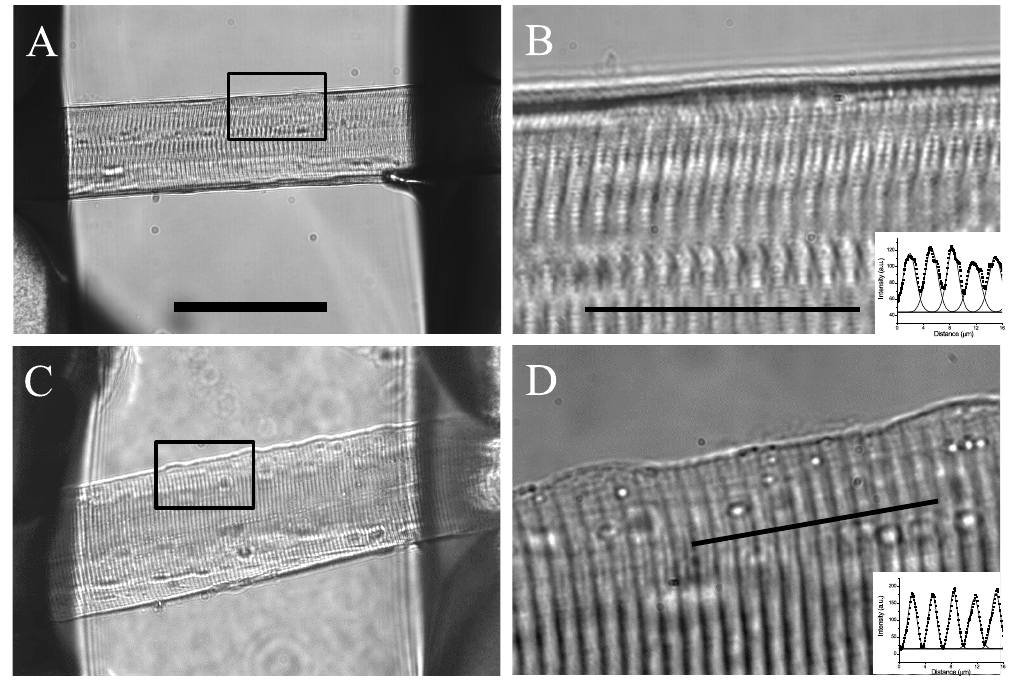
Figure 1. Isolated fibers mounted in the inverted double grease-gap chamber. Panel A: Image of a VL fiber from a healthy volunteer obtained with a 20 6 objective. The inner part of the grease seals delimiting the experimental pool can be seen at both sides of the image. Panel B: The area delimited by the square in A was imaged with a 100 6 immersion objective. A sharp banding pattern and smooth border can be seen. Panels C and D shows a VL fiber from a HF patient at the same magnifications as in A and B, respectively. The diameter and sarcomere length were 62.0 and 3.0 m m for the fiber in A, and 80 and 2.8 m m for the fiber in B, respectively. The insets in panels B and D show intensity profiles measured across , 4 sarcomeres. The profiles span , 16 mm along the directions indicated by the lines superimposed in the corresponding images. The dots and lines represent the intensity values and Gaussian fits to the data, respectively. The scale in A corresponds to 100 m m in A and C, and 20 m m in B and D.